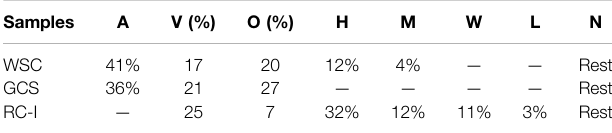
TABLE 5 | Mineral compositions of typical residual soils. Samples